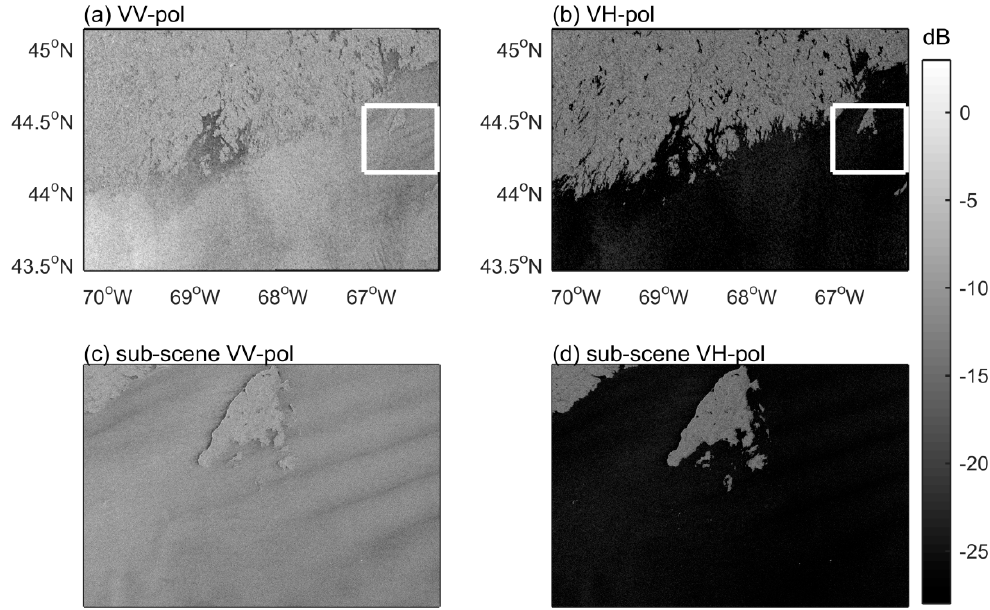
Figure 3. Dual-polarized RADARSAT-2 ScanSAR images in the Bay of Fundy (22:20 UTC, 14 May 2017): ( a ) VV-polarization, ( b ) VH-polarization, ( c ) VV-polarized sub-scene of the white box, and ( d ) VH-polarized sub-scene of the white box. RADARSAT-2 Data and Products MacDonald, Dettwiler, and Associates Ltd., All Rights Reserved.